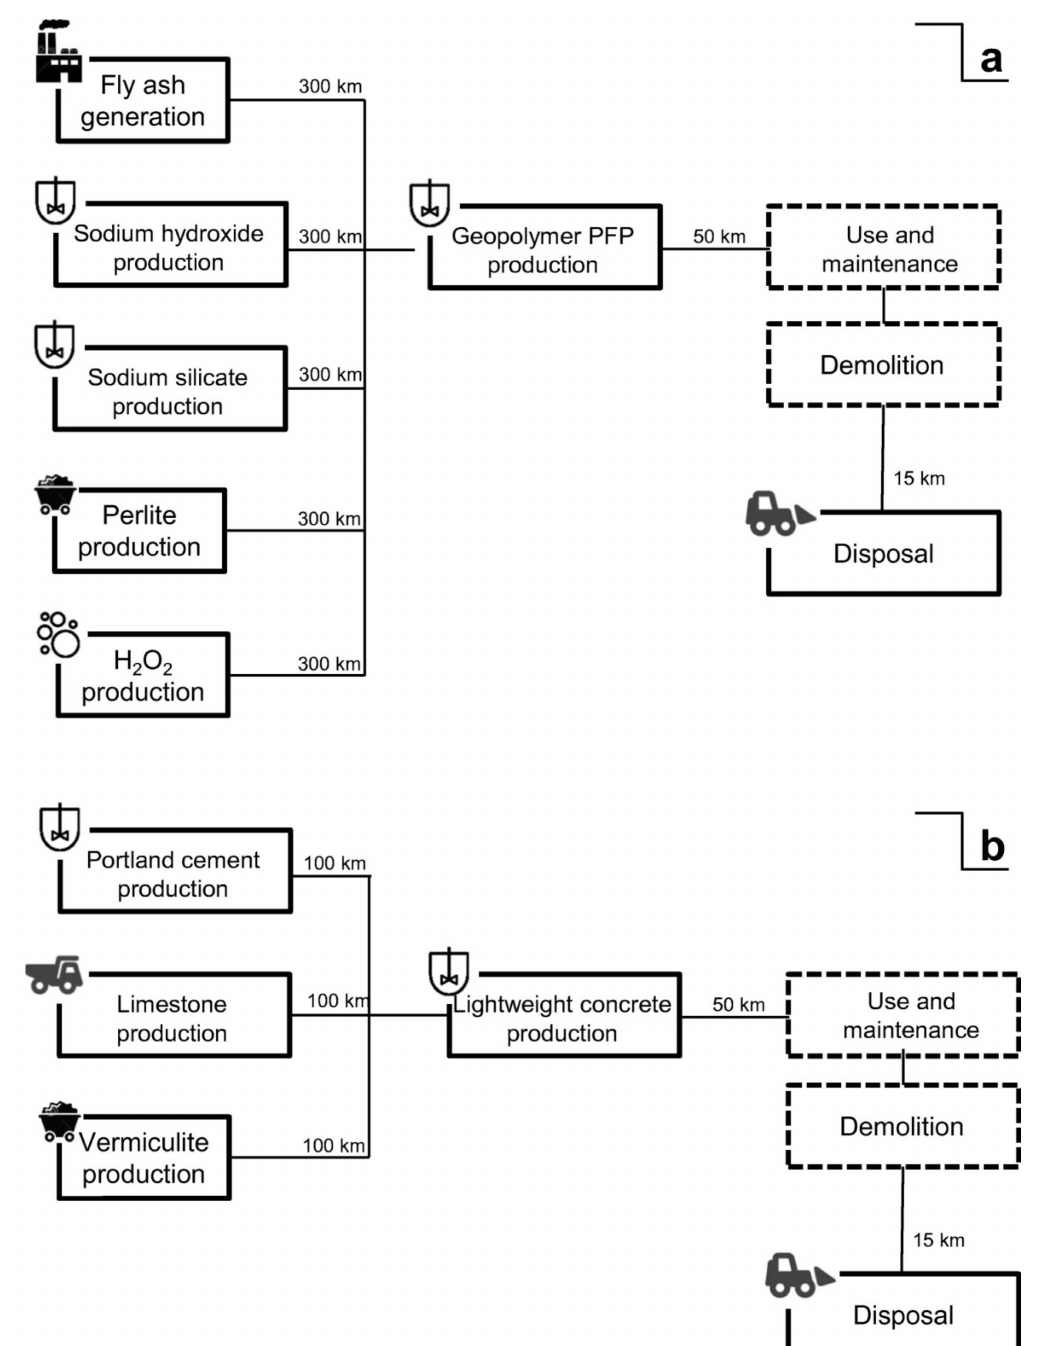
Figure 20. Main unit processes considered for ( a ) geopolymer based passive fire protection (PFP) mix and ( b ) lightweight concrete PFP mix in case B. Dashed box: processes outside system boundaries. Reprinted from [86], © 2020 with permission from Springer